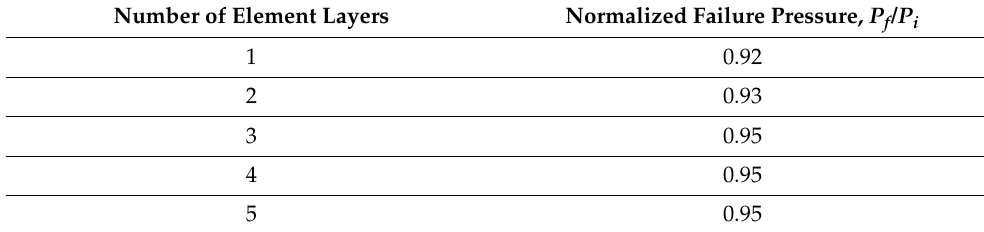
Table 5. Convergence test details and